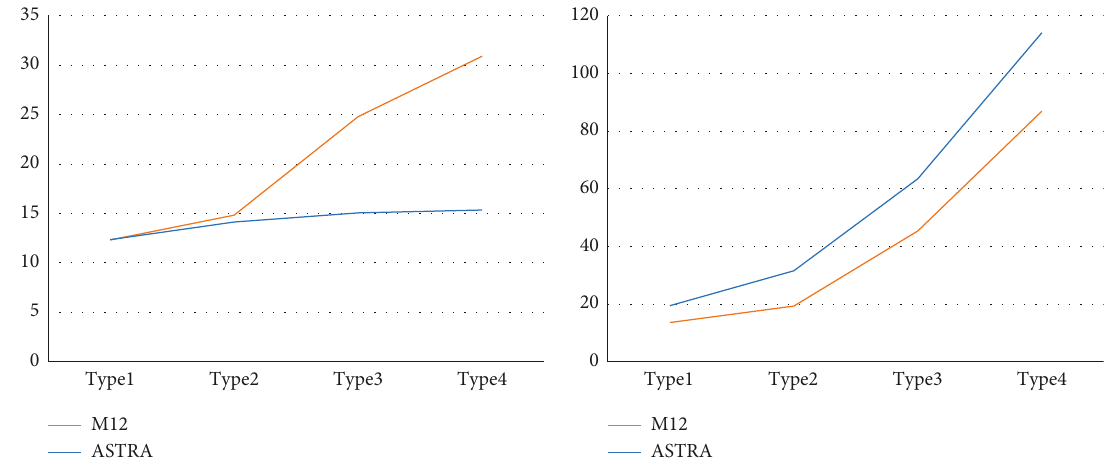
Figure 6: Maximum tension in the cortical and trabecular bone for the compressive load depending on the type of